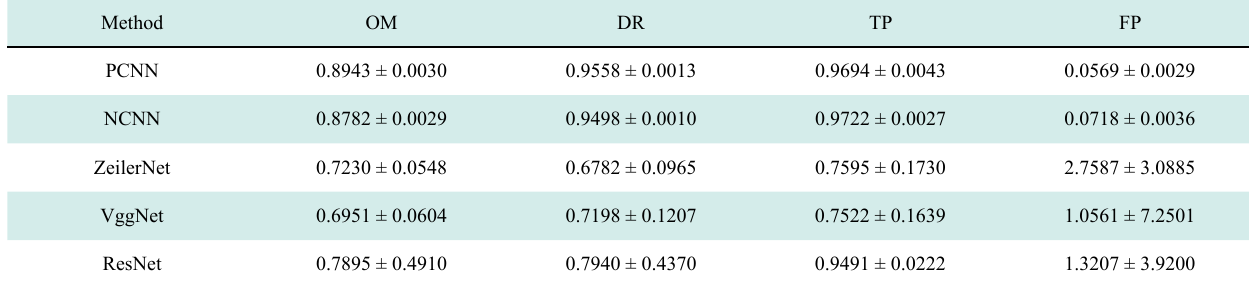
Table 2 Performance of the PCNN, NCNN, ZeilerNet, VggNet and ResNet used for thyroid nodules in this study. Method